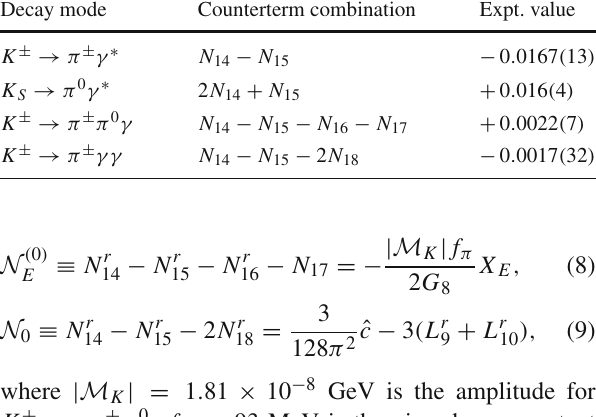
Table 1 Values of the counterterm combinations together with the decay mode from which they can most precisely be extracted Decay mode Counterterm combination Expt.